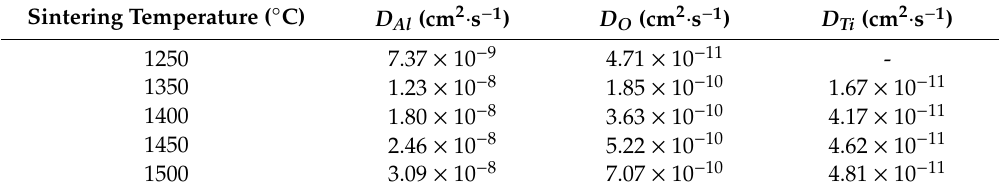
Table3. ElementsdiffusioncoefficientofTi / Al 2 O 3 compositesinterfaceatdifferentsinteringtemperatures. Sintering Temperature ( ◦